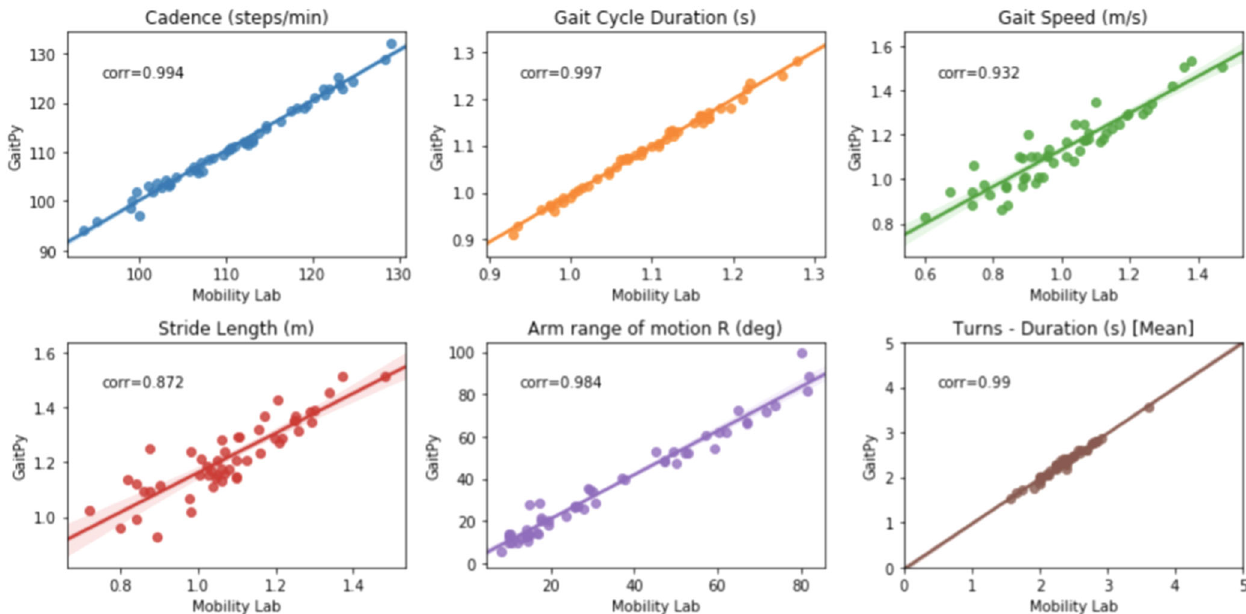
Fig. 2 Gait Features Comparison. Correlation between gait features calculated on the same measurements performed using Opal and using GaitPy and Mobility Lab correspondingly.